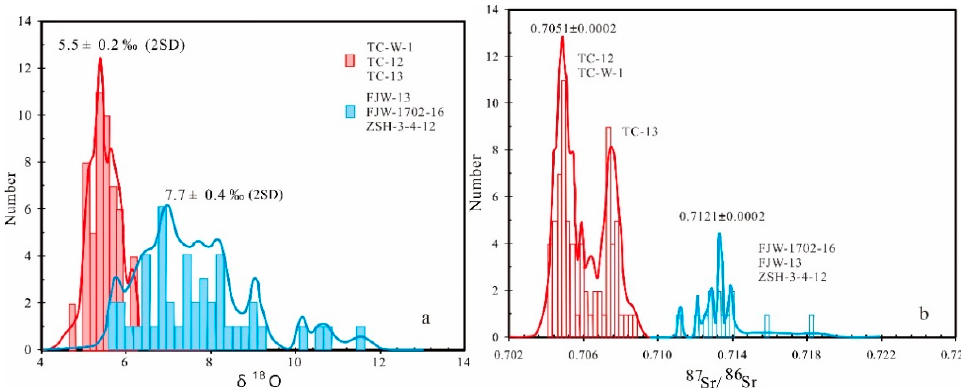
Figure 6. The In-situ δ 18 O and 87 Sr/ 86 Sr isotopes characteristics from Dexing porphyry and wall rocks . ( a ) Zircon oxygen isotope characteristics; ( b ) Apatite 87 Sr/ 86 Sr composition.